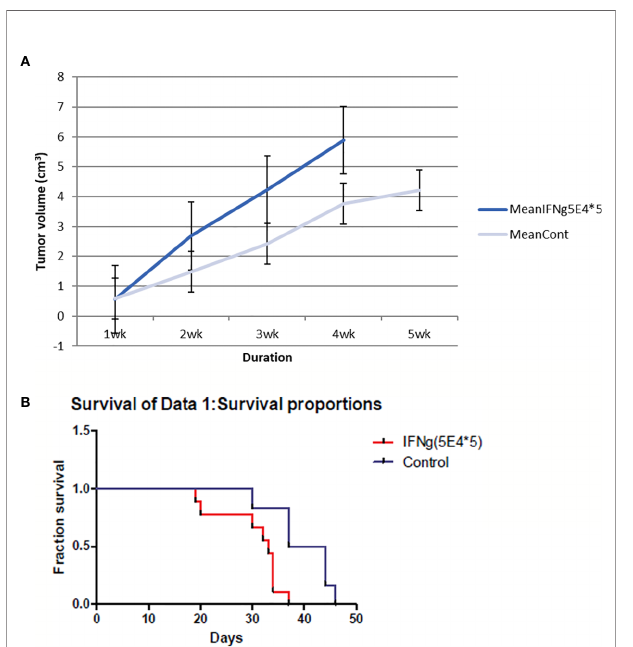
FIGURE 4 | NXS2 tumor volume and mice survival graph after IL-10 injection compared to control mice (n=10). (A) Tumor volume was measured every week after NSX2 cell inoculation with or without IL-10 treatment. Grey line means control group, dark blue line means the IL-10 group, light blue line is the 14G2A antibody group, and blue line is the 14G2A antibody plus IL-10 group. IL-10 therapy caused statistically signi fi cant tumor volume shrinkage. Antibody alone or antibody plus IL-10 caused mild-moderate tumor volume shrinkage. (standard error is used in the graph). (B) Mice survival was measured each week after NXS2 cell inoculation with or without IL-10 treatment. Green line means IL-10 treated group, black line means control group, blue line means 14G2A antibody group, and red